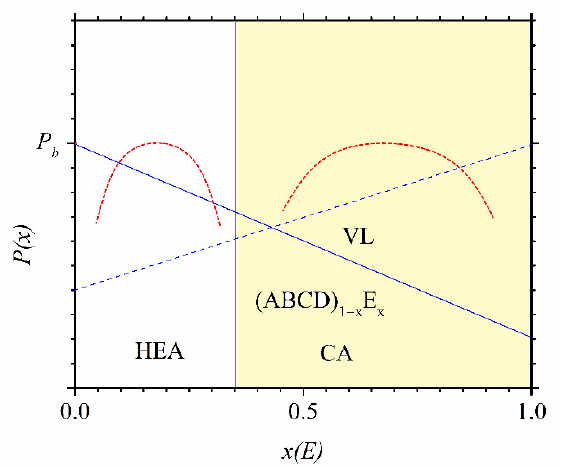
Figure 1. Some variations of a property P of a hypothetical (ABCD) 1 − x E x alloy with x . Straight lines illustrate variation according to Vegard’s law [60]. P b denotes a maximum value of P .